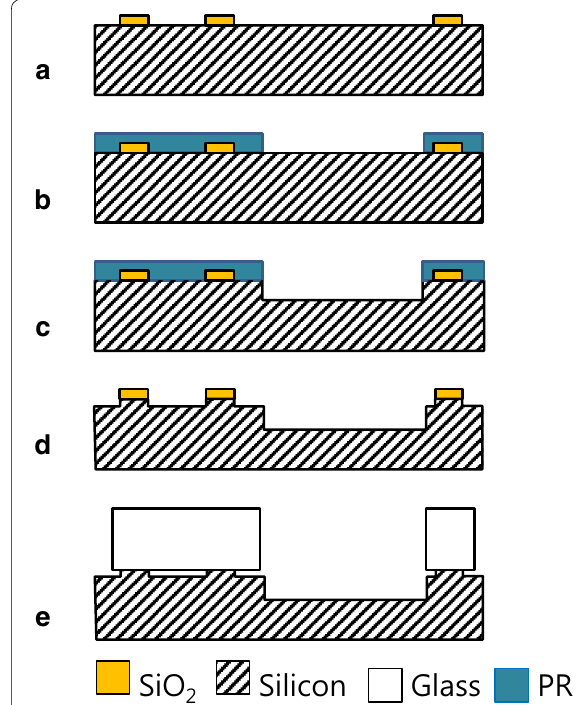
Fig. 2 The microfabrication process flow: a SiO 2 patterning and etching, b thick PR patterning, c Si reactive ion etching, d Si reactive ion etching after PR removal and SiO 2 removal, and e anodic bonding of the sand‑blasting etched glass substrate on the Si